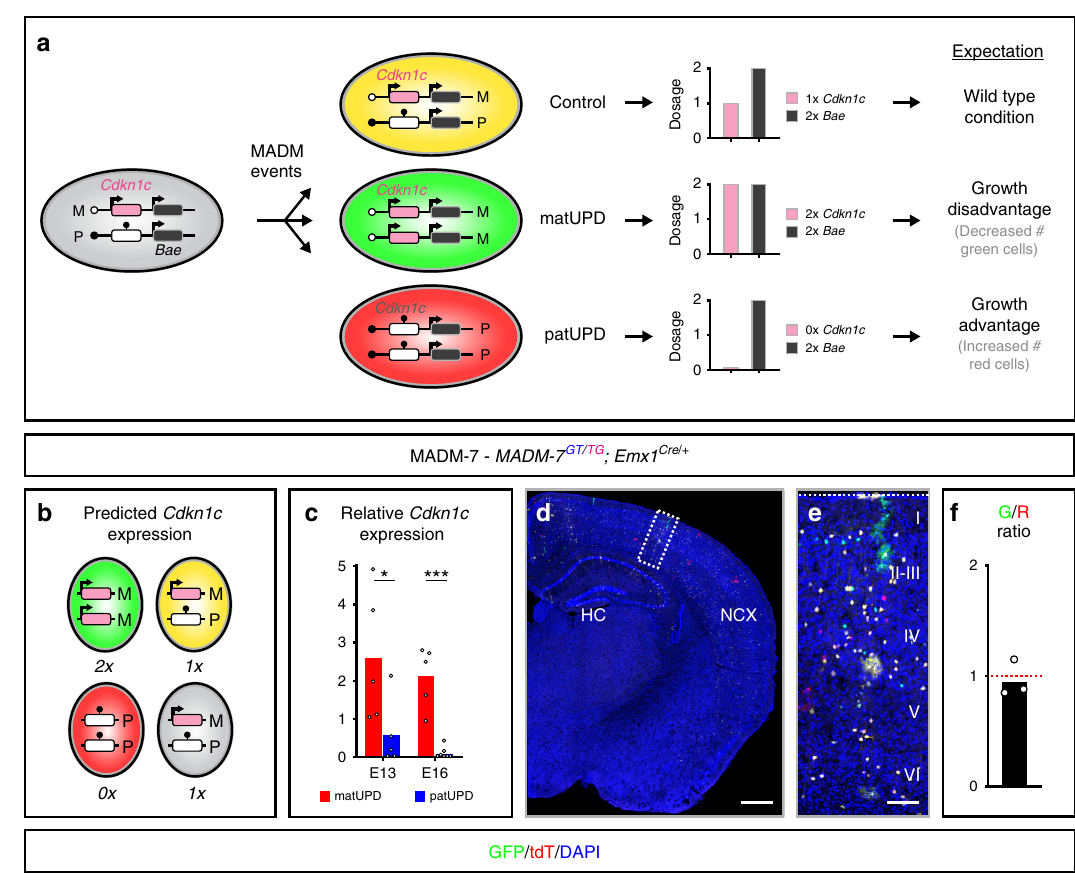
Fig. 1 MADM-based analysis of imprinted Cdkn1c gene function at single-cell level. a MADM recombination events result in distinct fl uorescent labeling of cells containing uniparental disomy (UPD). Yellow cells are control cells, green cells carry maternal uniparental chromosome disomy (matUPD) and red cells contain paternal uniparental chromosome disomy (patUPD). Cdkn1c is expressed from the maternal allele in yellow cells, which resembles the wild- type situation. In green cells (matUPD) Cdkn1c is expressed from both maternal alleles and predicted to result in growth/proliferation disadvantage (expression of two doses of a growth inhibitor). Red cells (patUPD) lack Cdkn1c expression and are expected to show growth/proliferation advantage due to lack of expression of a growth suppressor. b Schematic depicts green (GFP + ), red (tdT + ), yellow (GFP + /tdT + ) and unlabeled MADM cells with UPD (red, green) and control cells (yellow, unlabeled). Parental origin of chromosome is indicated (M, maternal; P, paternal). Imprinting status of Cdkn1c (arrow, expression; ball on stick, repression) and predicted expression (0×, 1×, 2×) is indicated. c Relative Cdkn1c expression in matUPD (red bars) and patUPD (blue bars) at E13 and E16. Bars represent mean. * p < 0.05, *** p < 0.001 (Wald test). Data points indicate individual animals ( n = 4 – 7). d MADM-labeling pattern in cerebral cortex of MADM-7 ( MADM-7 GT/TG ;Emx1 Cre/ + ) at P21. The parent from which the MADM cassettes were inherited is indicated in the respective genotypes in pink (mother) and blue (father). e Higher magni fi cation of cortical cross-section (boxed area in ( d )). f G/R ratio of single MADM- labeled cortical neurons is depicted as geometric mean. Note the equipotency of cells with matUPD and patUPD. Nuclei ( d , e ) were stained using 4',6- diamidino-2-phenylindole (DAPI, blue). Data points indicating individual animals ( n = 3). Source data are provided as a Source Data fi le. Scale bar, 500 μ m ( d ), 90 μ m ( e